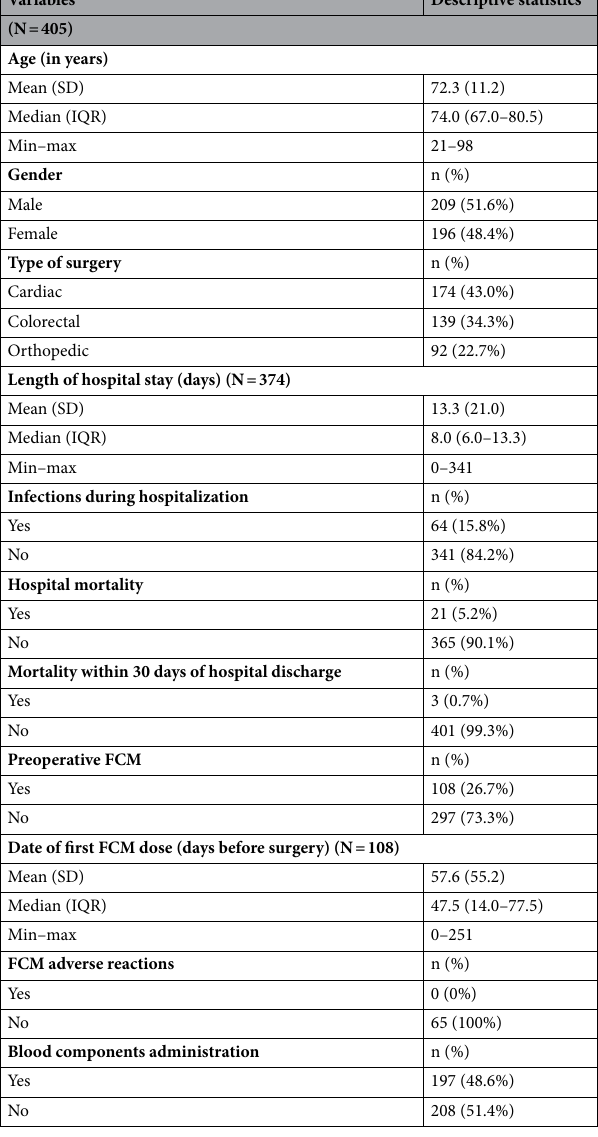
Table 1. Results of descriptive